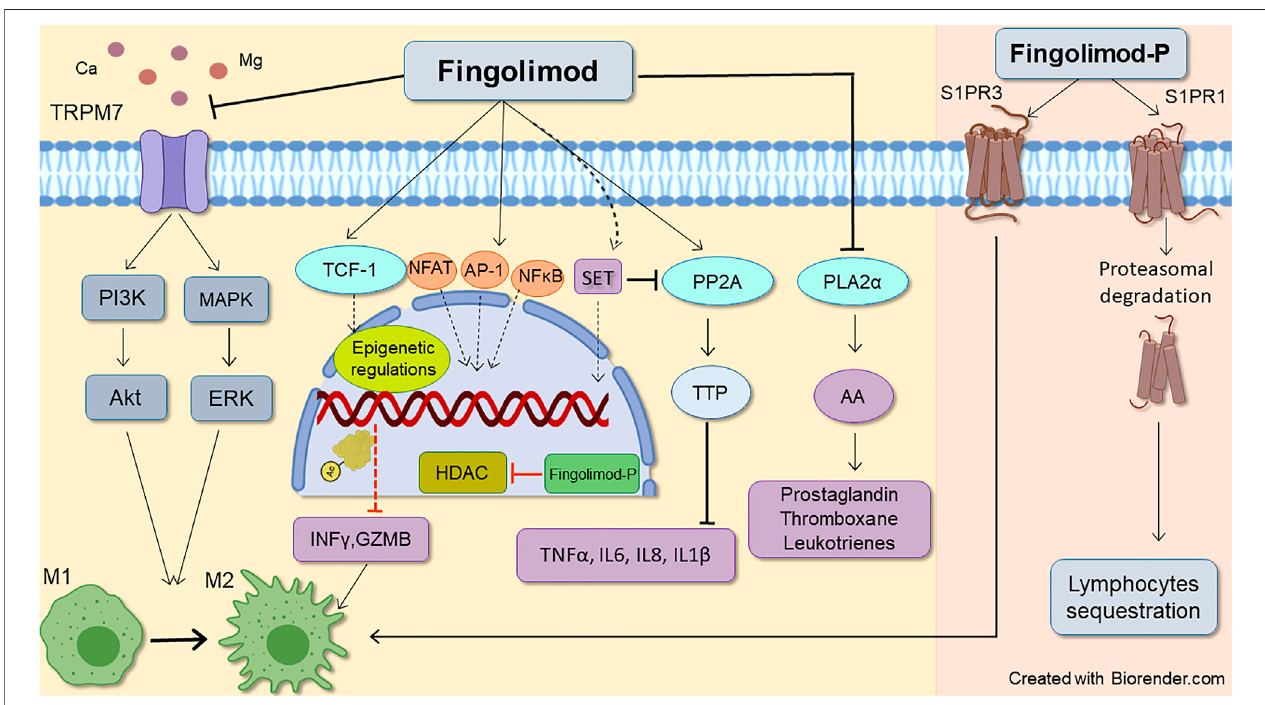
FIGURE2| Schematic representative of fi ngolimod anti-in fl ammatorymode ofaction. Fingolimod main immunomodulatory action occurs through downregulating S1P receptors1, leading to lymphocytes sequestration. Its action on S1P receptors3 also favors lymphocytes M2 anti-in fl ammatory phenotype which is mediated by STAT3phosphorylation.Besides,non-S1Prelatedactionsof fi ngolimodalsocanreducein fl ammatoryresponsebydecreasingin fl ammatorymolecules,T-cellinhibition, and shifting microglia and macrophages toward M2 phenotype. Enhancing histone acetylation by epigenetic regulation, phospholipase A2 α inhibition, and activation of PL2A (through inhibition of SET expression) by fi ngolimod reduces in fl ammatory cytokines such as TNF α , IL6, IL8, and IL-1 β . The drug also inhibits PLA2 α (which contributes to AA release and subsequent prostaglandins production), and TRPM7 chanzyme (which can induce both pro and anti-in fl ammatory phenotypes in macrophages). AA, Acid arachidonic; AP-1, Activator protein 1; Fingolimod-P, Fingolimod phosphate; GZMB, granzyme B; HDACi, Histone deacetylate inhibition, IL (6, 8), Interleukin (6, 8); INF ϒ , interferon-gamma; M1, Pro-in fl ammatory macrophage/microglia; M2, Anti-in fl ammatory macrophage/microglia NFAT1, Nuclear factor of activatedT-cells1;NF κ B,Nuclearfactor-kappaB;PLA2 α ,Phospholipase2 α ;PP2A,Proteinphosphatase2A;TCF-1,Tcellfactor1;TNF α ,Tumornecrosisfactoralpha; TTP,